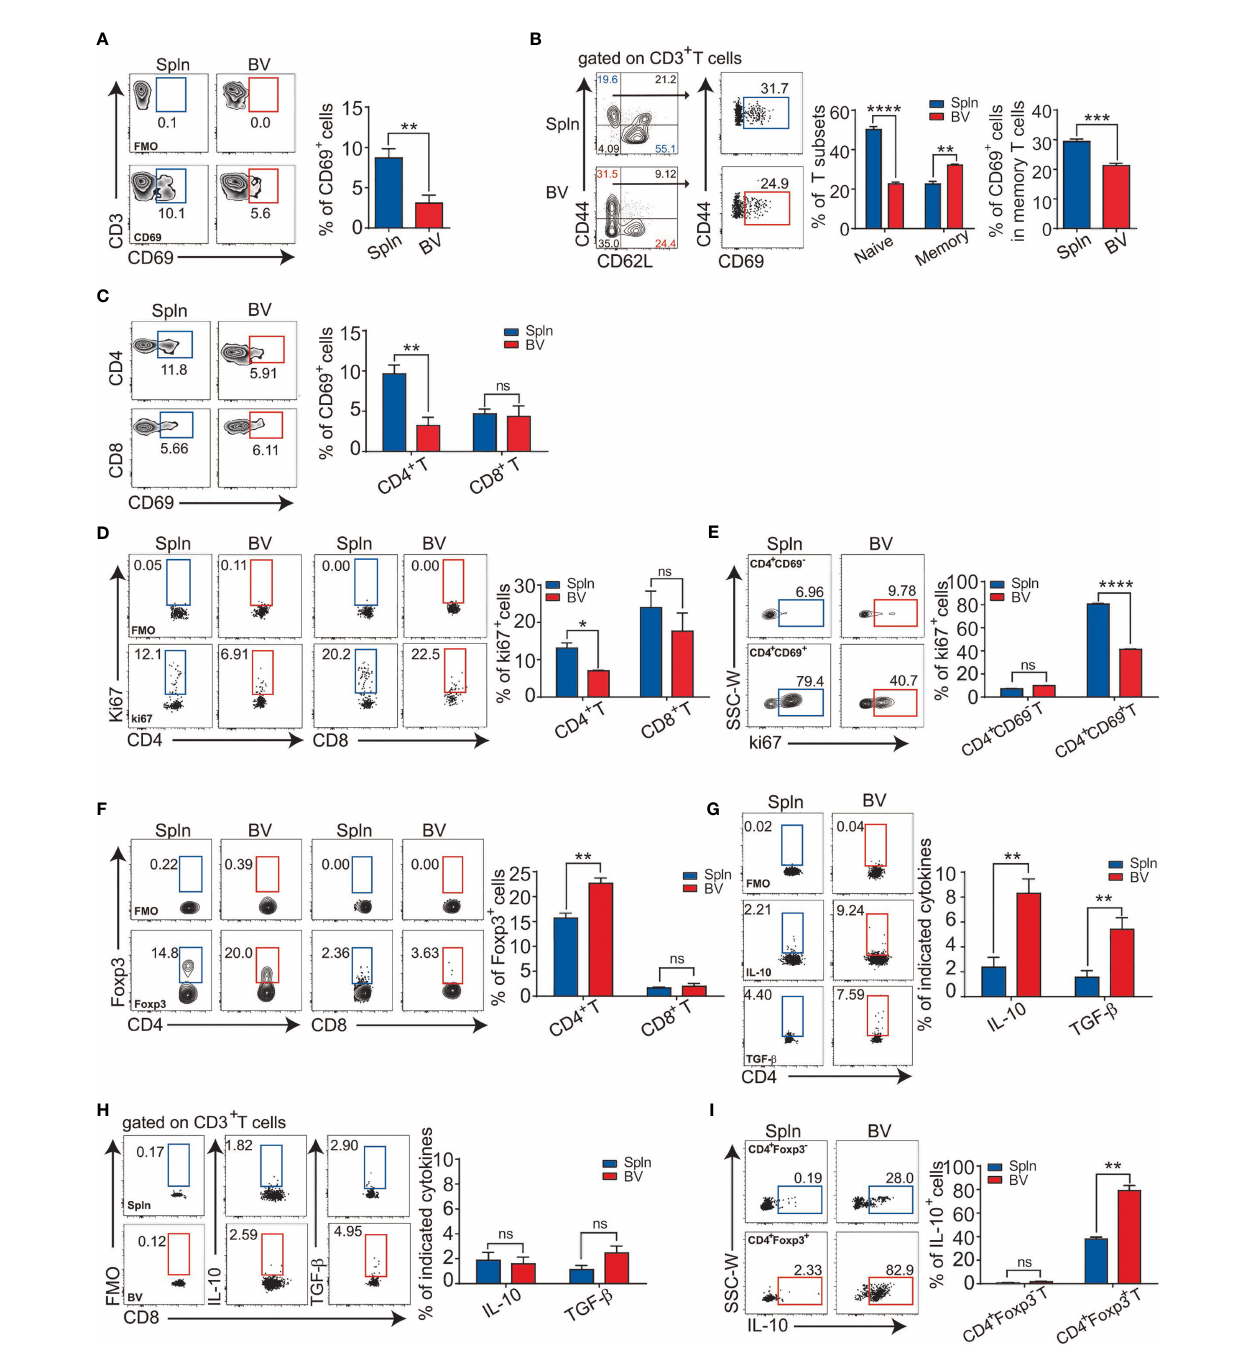
FIGURE 3 | Immunologically suppressed phenotypes of vascular T cells at steady state. Tissue single-cell suspensions from BV and Spln of healthy mice were prepared and gated for FACS analysis as in Figure 1 . Plots and bar graphs show the percentage of CD69 in T cells (A) , their naïve vs. effector fractions (B) , and T- cell subsets (C) ; percentage of cells positive for Ki67 (D) , and the proportion of Ki67 in CD4 + CD69 − and CD4 + CD69 + T cells ( E ); Foxp3 (F) in CD4 + and CD8 + T cells; cytokine contents of IL-10/TGF- b 1 in CD4 + (G) and CD8 + T cells (H) , as wells as IL-10 in CD4 + Foxp3 − and CD4 + Foxp3 + T cells (I) . Shown here are representative plots of experiments with at least three biological replicates. The data are shown as mean ± SEM and analyzed using Student ’ s t -test. * p < 0.05; ** p < 0.01; *** p < 0.001; **** p < 0.0001. ns, no signi fi cant